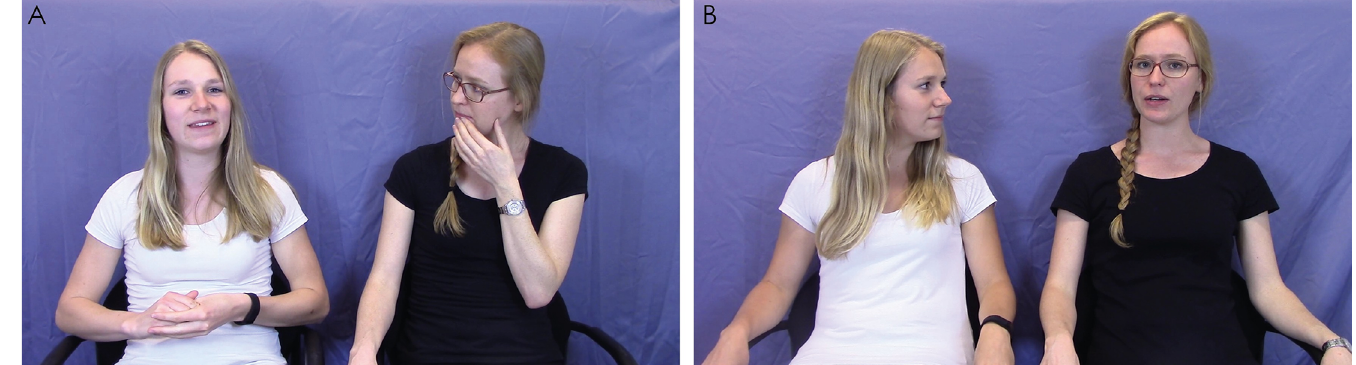
Fig 1. Still frames from story stimuli videos. A: Experimental condition: the experimenter on the left is performing the hand rub behavior while telling her story and the experimenter on the right is performing the face rub. B: Control condition. The researchers pictured in this figure have given written informed consent (as outlined in PLOS consent form) for publication of this